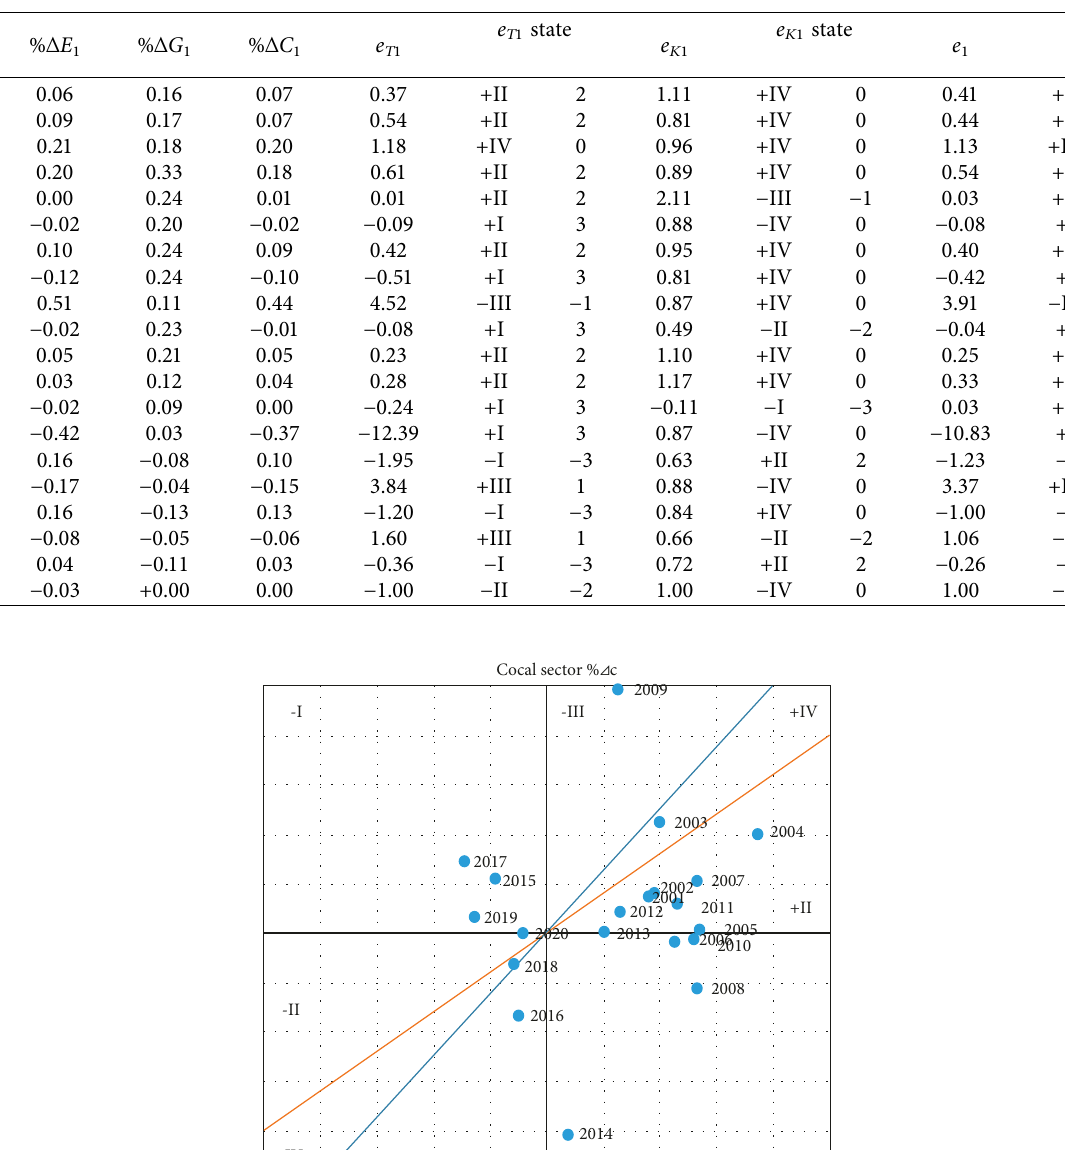
Figure 7: Analysis on the proportion of carbon emissions of various sectors from 2000 to 2020. Table 8: Decoupling index and decoupling relationship of the coal sector from 2001 to 2020.